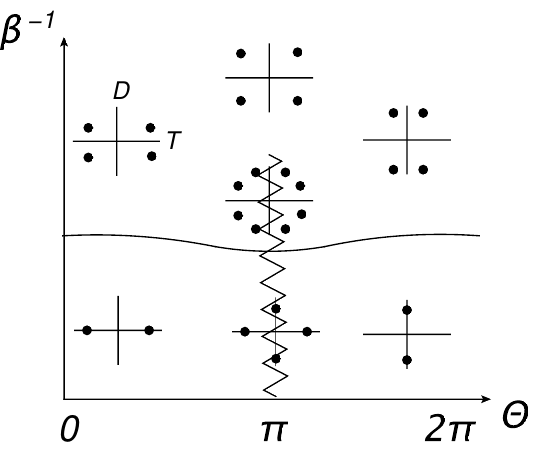
Figure 4 . The phase diagram in the mixed theory (as in figure 2), where in the region with question marks we assume that the first order line continues to higher temperatures beyond the deconfinement